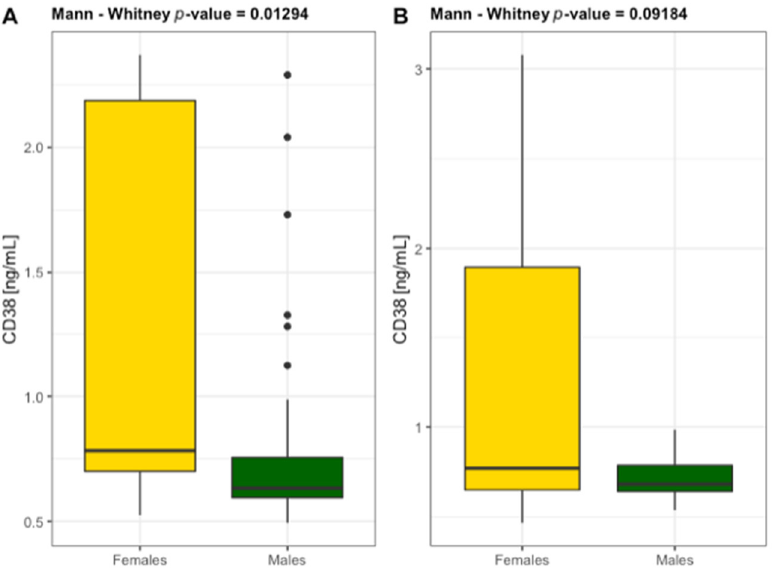
Figure 4. Differentiation of the level of hematopoietic progenitor cells CD34 in females and males diagnosed with PAD ( A ) n = 59 and without PAD ( B ) n = 60.